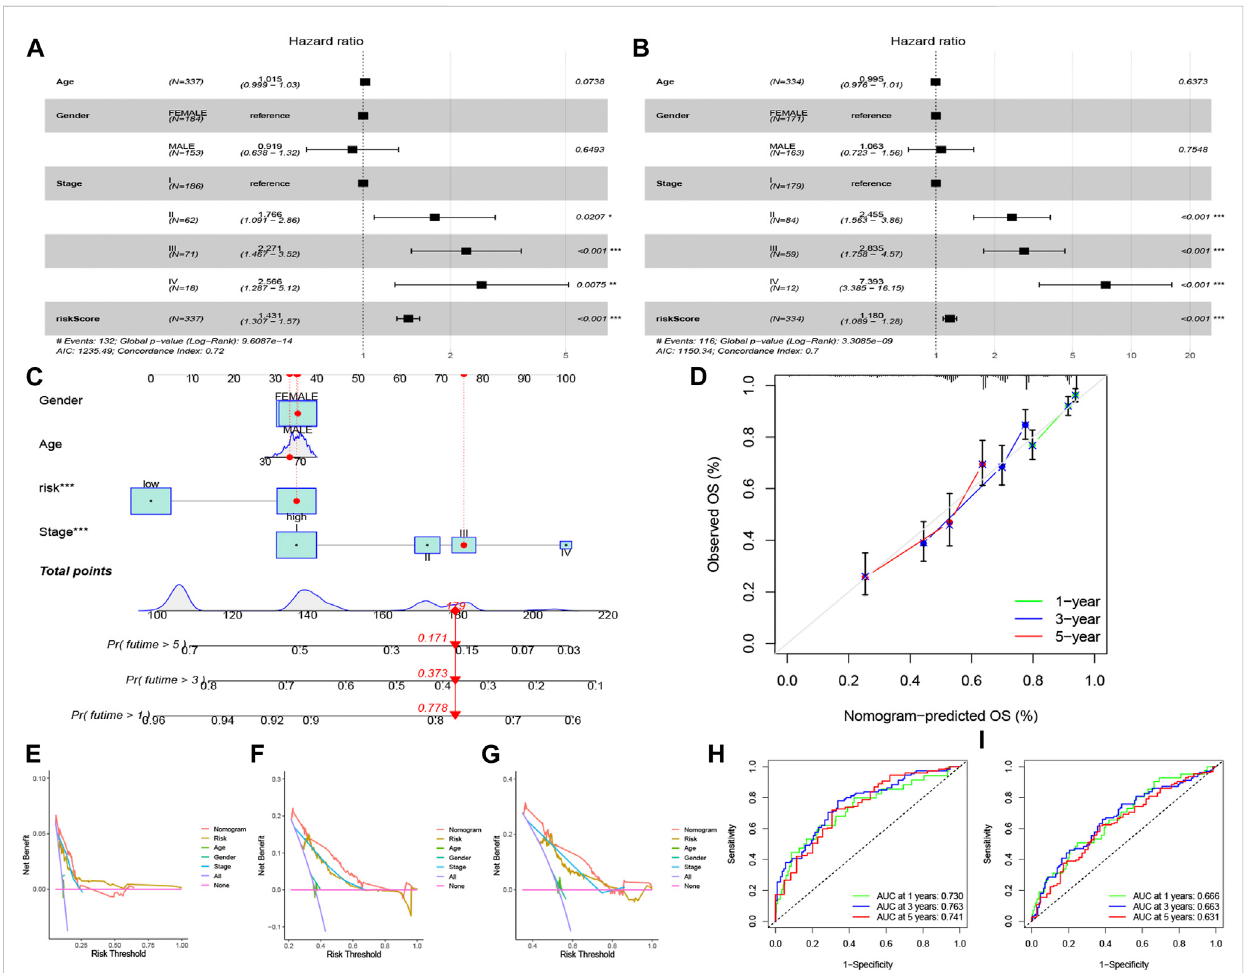
FIGURE 5 Independent prognostic analysis and nomogram construction for LUAD. Univariate Cox regression analysis in training group (A) and testing group (B) ofclinicalfeaturesintheriskmodelset( p < 0.05). (C) Theconstructionofnomogramtoforetellpatient ’ s1-,3-,and5-yearsurvivalrates,accordingto the total points. (D) Calibration curve of the nomogram. (E – G) C-index curve for different variables, including risk score, age, gender, and stage. ROC curves for 1 -, 3 -, and 5-year overall survival in training group (H) and testing group (I)